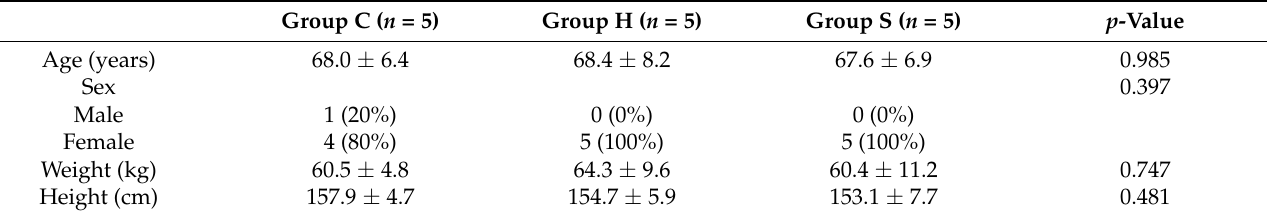
Table 1. Basic demographic data.